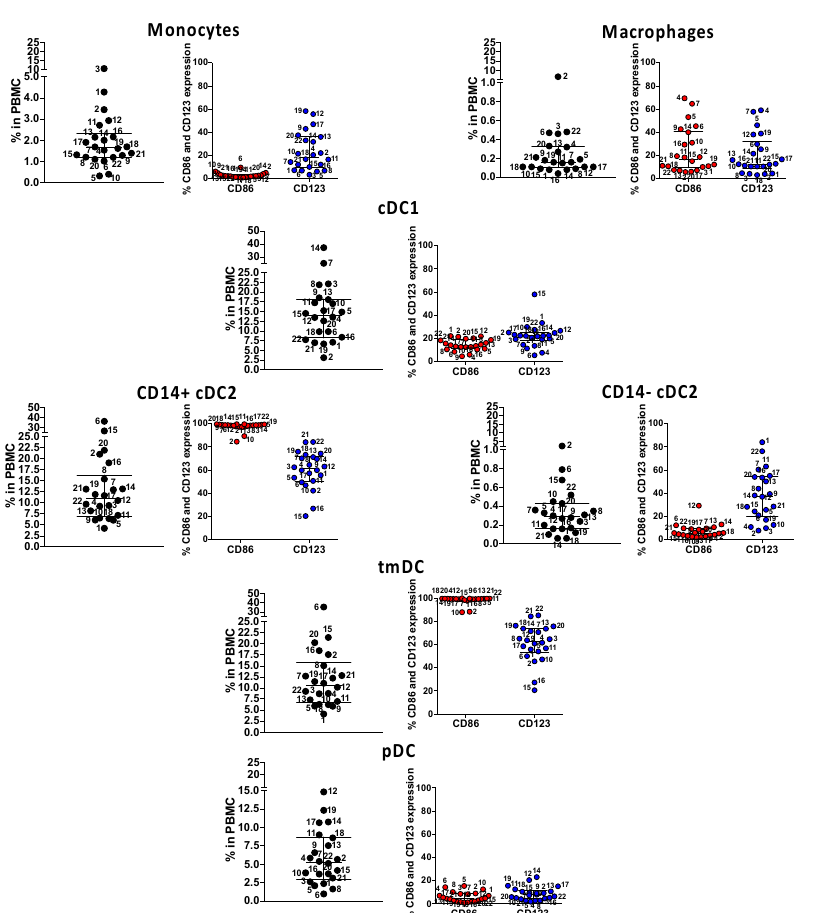
Figure 5. Immune phenotyping of circulating innate antigen presenting cells (APC) in subacute MIS-C subjects. We enumerated APC populations with a combination of monoclonal antibodies in all the 22 MIS-C subjects studied for SARS-CoV-2 T cell responses in their subacute phase by staining the same PBMC preparations. Monocytes were defined as CD14+ CD11c − CD11b − ; macrophages were defined as CD14+ CD11c − CD11b+; myeloid cDC1 were defined as CD11c+ CD11b − CD14 − ; myeloid cDC2 (CD14+ or CD14 − ) CD11c+ CD11b+, tmDC were defined as CD11c+ CD11b+ CD4+ ILT-4+; and pDC was defined as CD14 − CD11c − CD11b − CD123+. The activation/maturation markers CD86 (red symbols) and CD123 (blue symbols) are shown next to the population. Symbols represent data derived from each individual subject. Median ± interquartile ranges are indicated in the figure. CD14+ cDC2 and CD11c+ CD11b+ CD14+ CD4+ ILT-4+, functionally tolerogenic, were the most activated, as shown by the expression of CD86 and CD123.